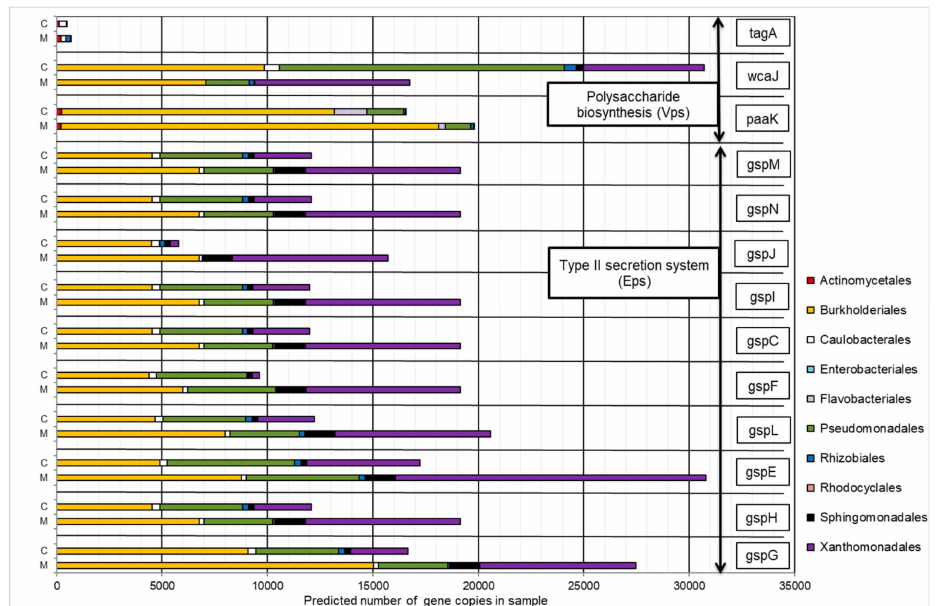
Figure 6. The contribution of the predicted number of gene copies involved in EPS synthesis to bacteria orders in the control sample (C) and in a sample containing 150 mg · L − 1 of heavy metals